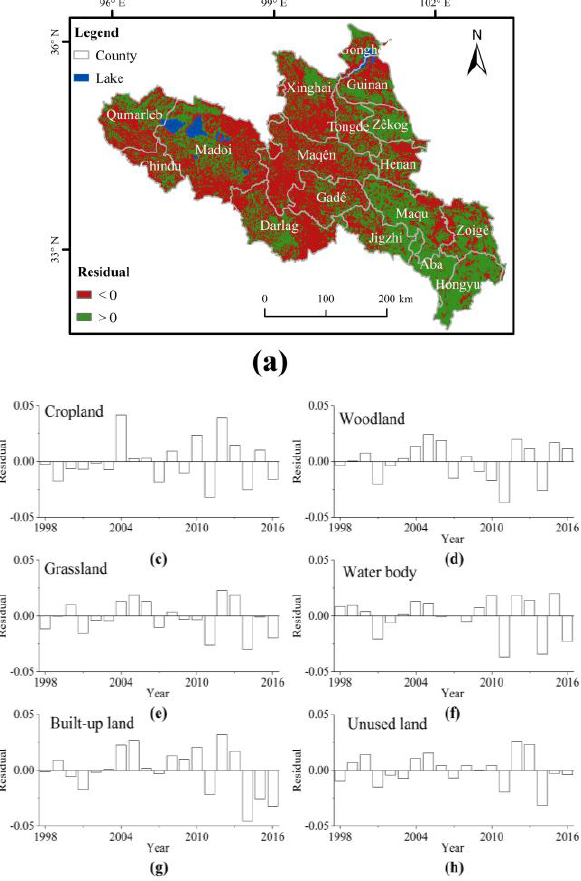
Figure 6. Residual analysis for NDVI :(a)Spatial distribution of the Yellow River source region; (b) Temporal series of the Yellow River source region. (c) Temporal series of the cropland; (d) Temporal series of the woodland; (e) Temporal series of the grassland; (f) Temporal series of the water body; (g) Temporal series of the built-up land; (h) Temporal series of the unused